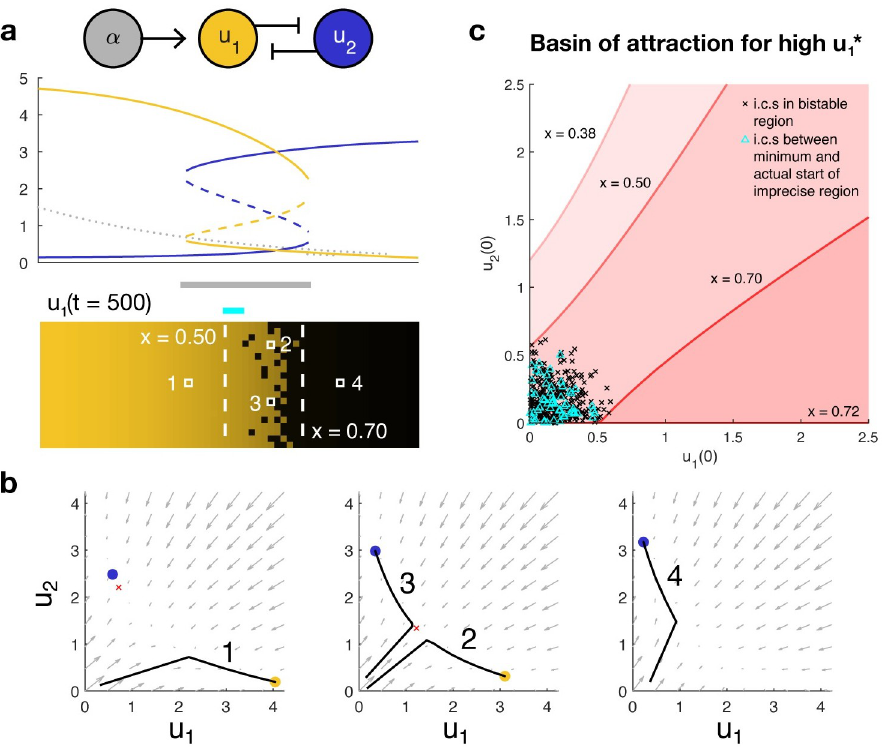
Fig 1. (a) A bistable toggle switch can produce a gene expression boundary from a morphogen gradient . Top, the morphogen (gray) induces expression of u 1 (gold), which is mutually repressive with species u 2 (blue). The morphogen concentration causes the anterior (left) of the boundary to be monostable in favor of high u 1 and the posterior (right) to be monostable in favor of high u 2 . In the bistable region of the boundary itself, the initial conditions determine whether cells express high u 1 or high u 2 at steady state. Middle, a bifurcation diagram indicates the value of the steady states, with solid lines indicating stability and dashed lines, instability. Bottom, a heat map of u 1 concentration at steady state showcases how variation in initial conditions among rows may result in an imprecise boundary in the bistable region. (b) Phase portraits at different x coordinates along the embryo predict how trajectories evolve over time . Gray arrows indicate the direction in which a trajectory will travel. Solid dots indicate stable steady states favoring high u 1 (gold) or high u 2 (blue). The unstable middle point in the bistable region is denoted by a red × . Black lines are example trajectories corresponding to the cells labeled above. (c) The boundaries of the imprecise region are determined by the basins of attraction that bound the initial conditions . Red shaded regions beneath each red curve denote the sets of initial conditions that will converge to the state with high u � at a fixed coordinate x . Black × denote 1 the initial conditions of all cells in the bistable region. The distance between the lowest and highest x that most tightly bounds these conditions (here, x a = 0.50 and x p = 0.70) is the most conservative estimate of the width of the imprecise region. The actual distribution of initial conditions may cause the actual width of the region to be smaller; for example, here, the initial conditions for the anteriormost cells within the bistable region (cyan 4 ) are upper bounded by a higher x than are the black ×